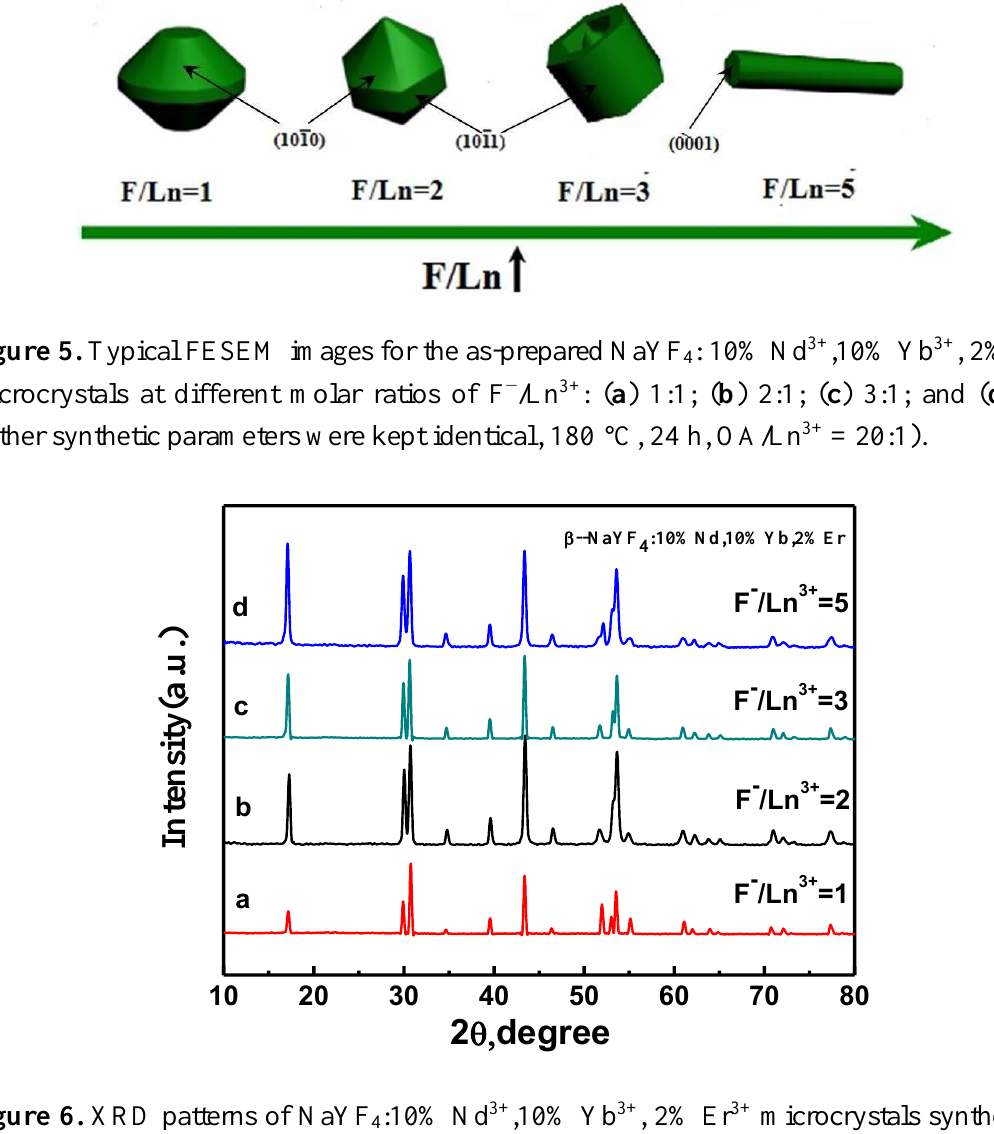
Figure 6. XRD patterns of NaYF :10% Nd 3+ ,10% Yb 3+ , 2% Er 3+ microcrystals synthesized 4 at different molar ratios of F − /Ln 3+ : ( a ) 1:1; ( b ) 2:1; ( c ) 3:1; and ( d ) 5:1 (Other synthetic parameters were kept identical, 180 °C, 24 h, OA/Ln 3+ =